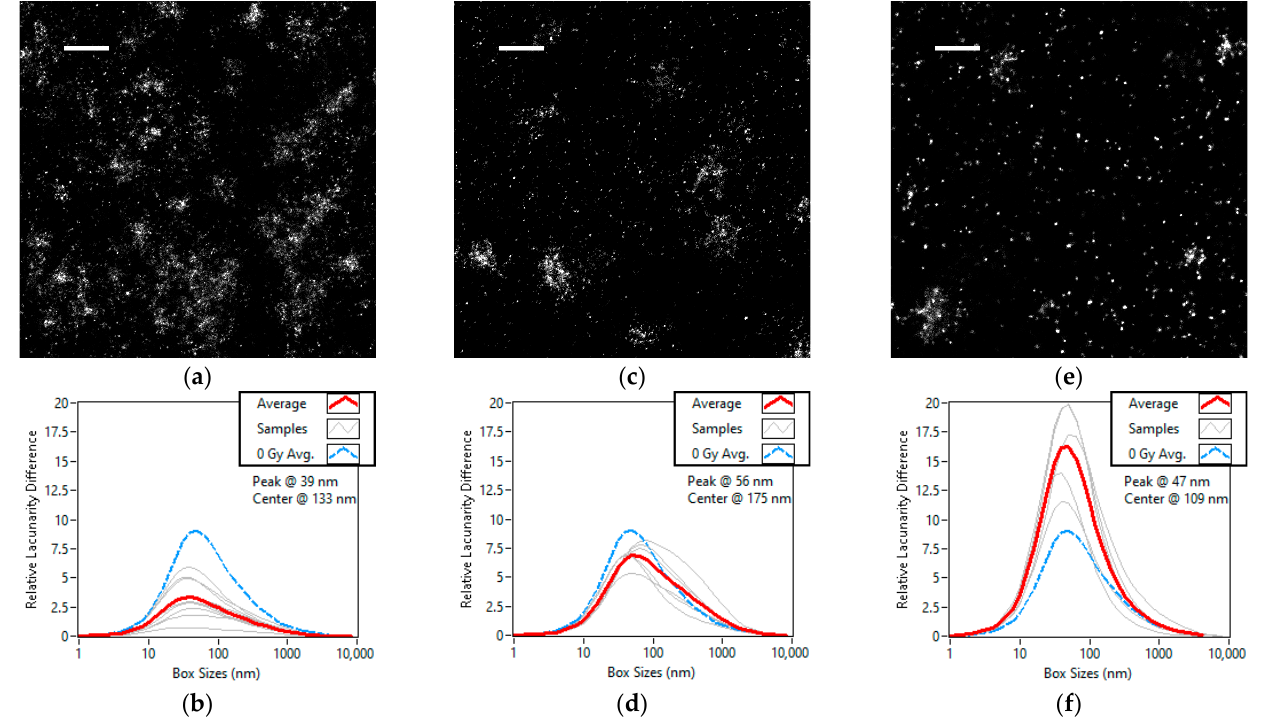
Figure 6. Super-resolution images and lacunarity difference curves of A647 labelled γ H2AX in the nuclei of U2OS cells grouped by time after treatment. The cells were observed 30 min ( a , b ), 24 h ( c , d ) and 72 h ( e , f ) after being subjected to 5 Grays of ionizing radiation. Scale bars are 1 µm. The number of studied cells is 9, 6 and 5, respectively. On each lacunarity difference curve, the average of the curves for each cell is shown in red and the average of the untreated U2OS is shown in dashed blue.